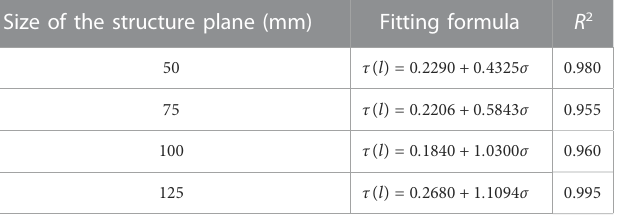
TABLE 12 Fitting model between shear strengths of structural planes and sizes (Gao, 2020). Size of the structure plane (mm) Fitting